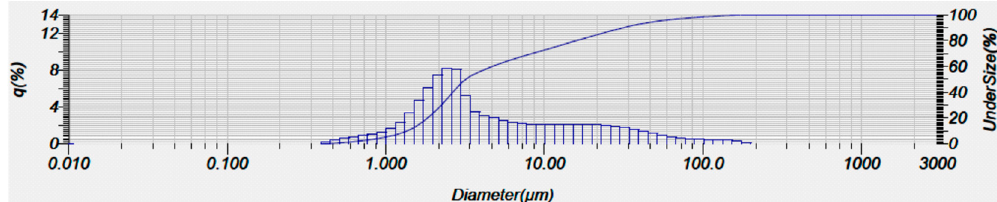
Figure 5. Normal distribution of LS.